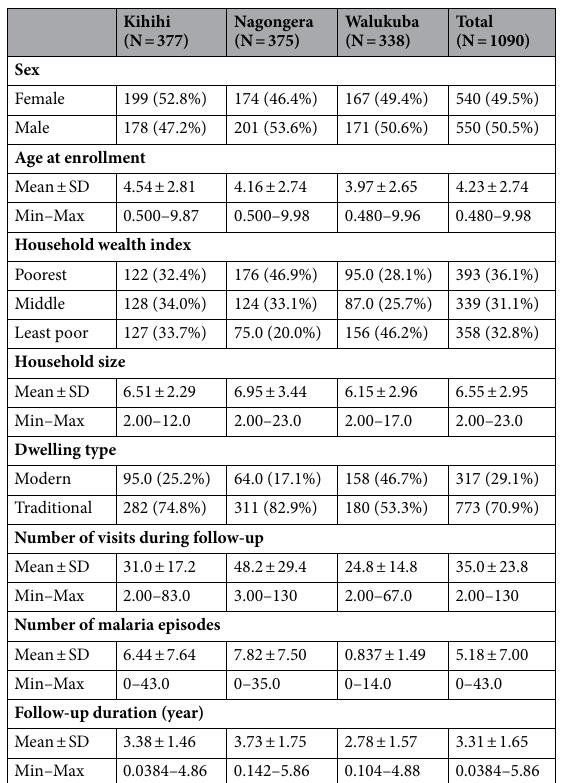
Table 1. Characteristics of study participants and